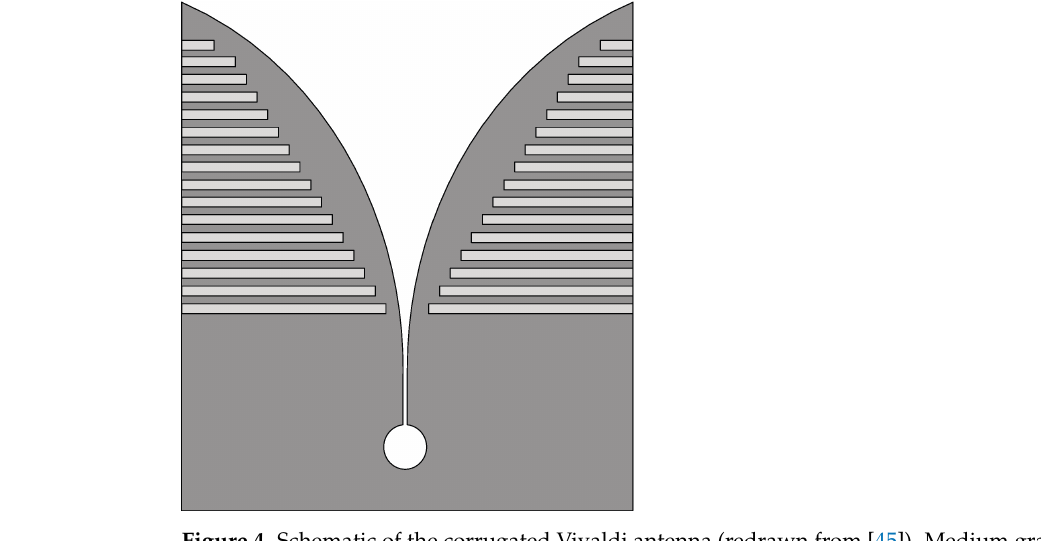
Figure 4. Schematic of the corrugated Vivaldi antenna (redrawn from [45]). Medium gray metal face and light gray slots.